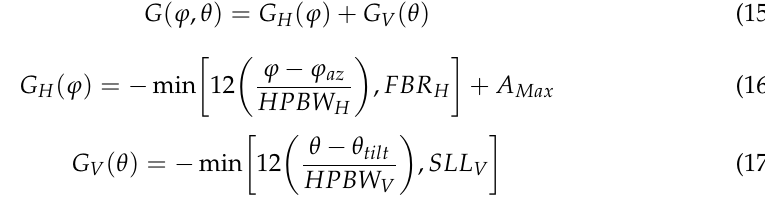
Table 2. Extended 3GPP antenna model